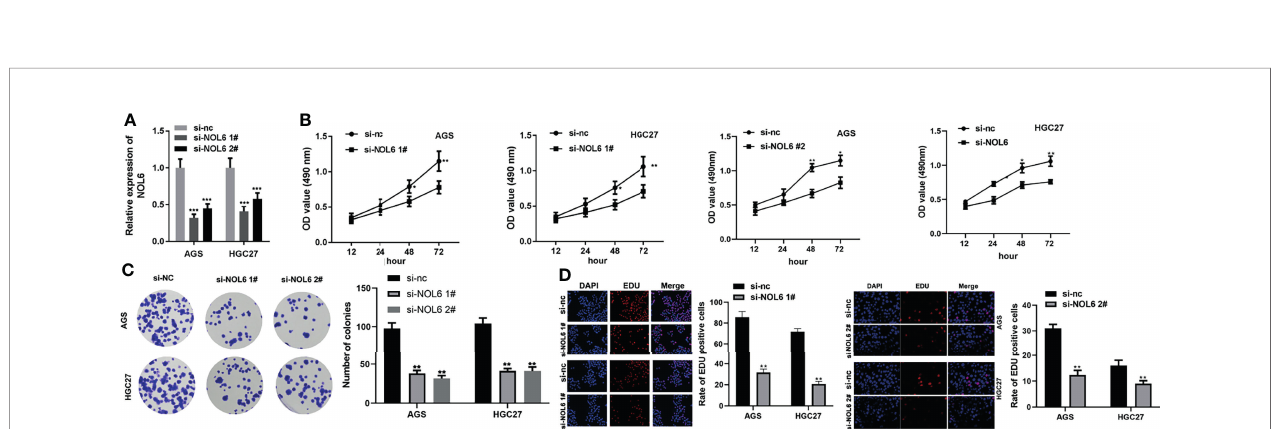
FIGURE 3 | Over-expression of NOL6 decreased the apoptosis of AGS and HGC cells. (A, B) Flow cytometry was performed to measure the apoptosis rate of AGS and HGC cells. (**p < 0.01